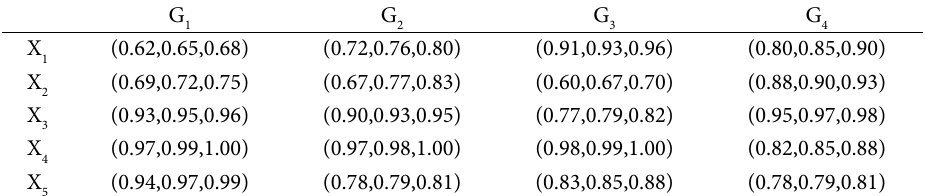
Table 3. Decision matrix